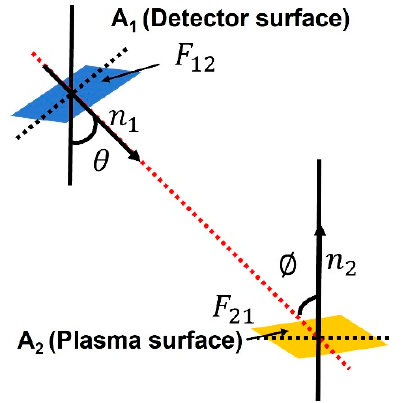
Figure 7. Schematic diagram of view factor between two surfaces.